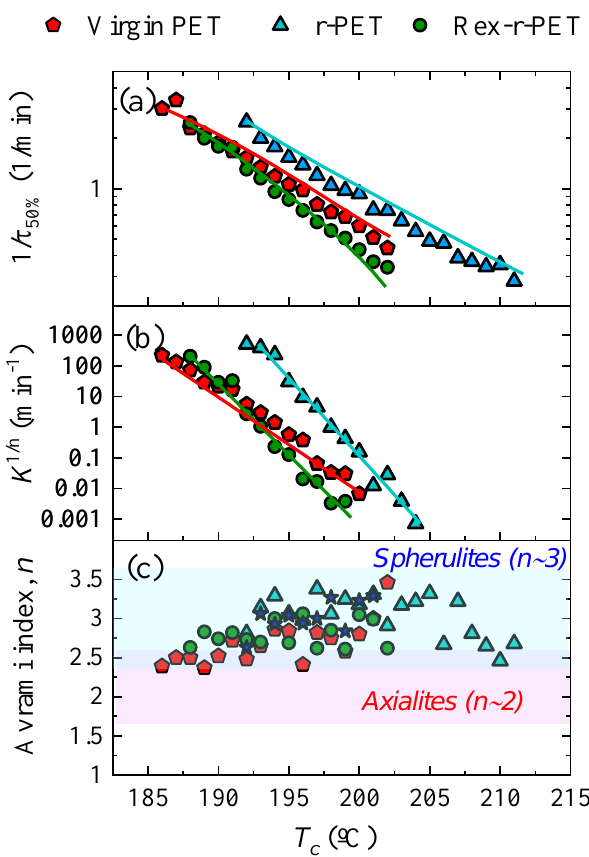
Figure 7. ( a ) Overall crystallization rates, indicated as the inverse of the experimentally determined half-crystallization times presented on a logarithmic scale, ( b ) normalized crystallisation constant obtained from the Avrami model presented on a logarithmic scale, and ( c ) Avrami index for the indicated PET samples as a function of the crystallization temperature, T c . Solid lines in ( a ) and ( b ) correspond to the fit of the Lauritzen–Hoffman (L–H) theory.